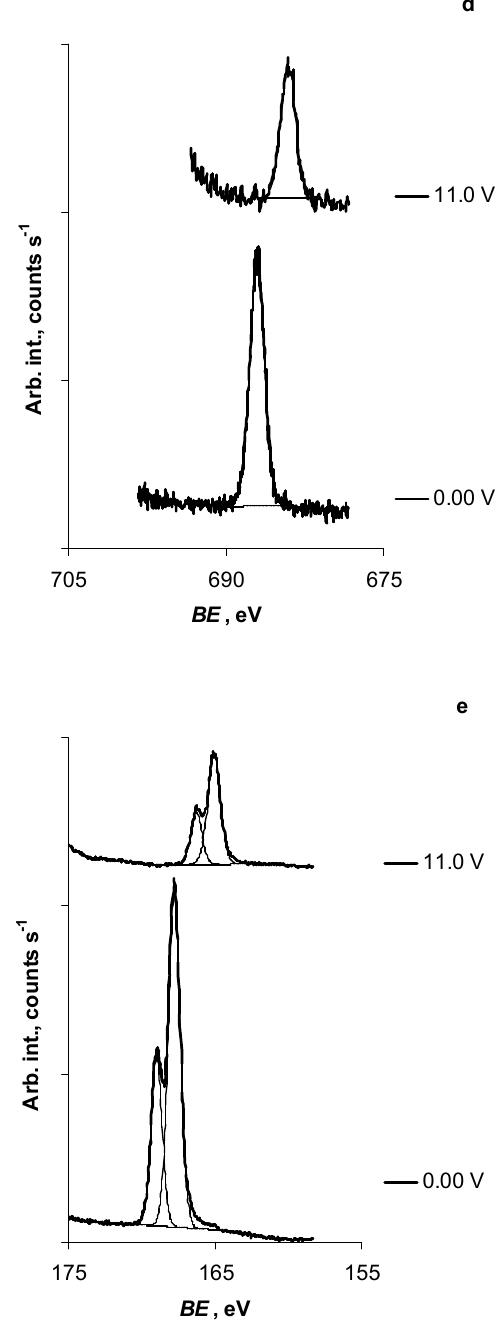
Figure 1. In situ XPS (i.e., core-electron binding energy, BE ) data measured at variable Al-electrode potentials (marked in figures) for C 1s, tick mark labels 100 counts s − 1 ( a ); for N 1s, tick mark labels 20 counts s − 1 ( b ); for O 1s, tick mark labels 30 counts s − 1 ( c ); for F 1s, tick mark labels 40 counts s − 1 ( d ); and for S 2p, tick mark labels 400 counts s − 1 ( e ).